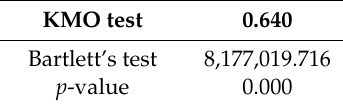
Table 3. Results of the Kaiser–Meyer–Olkin (KMO) test and the Bartlett’s test.